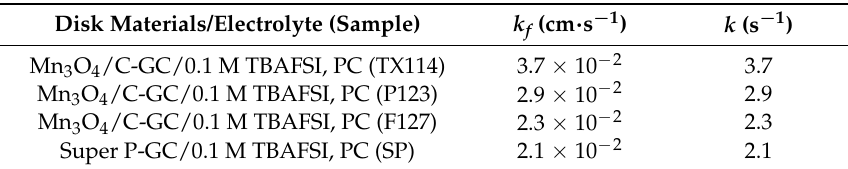
Table 3. The rate constant for the production of O 2 •− , k f , and the PC-electrolyte decomposition rate constant, k , for the different sample electrodes.